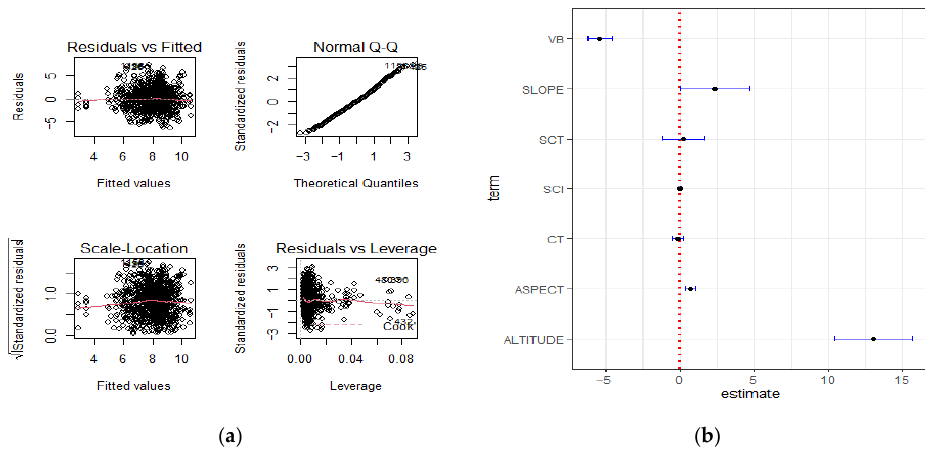
Figure 2. ( a ). Multiple linear regression. Diagnosis diagram of Fit1. ( b ). Multiple linear regression. The weighted graph of Fit1.